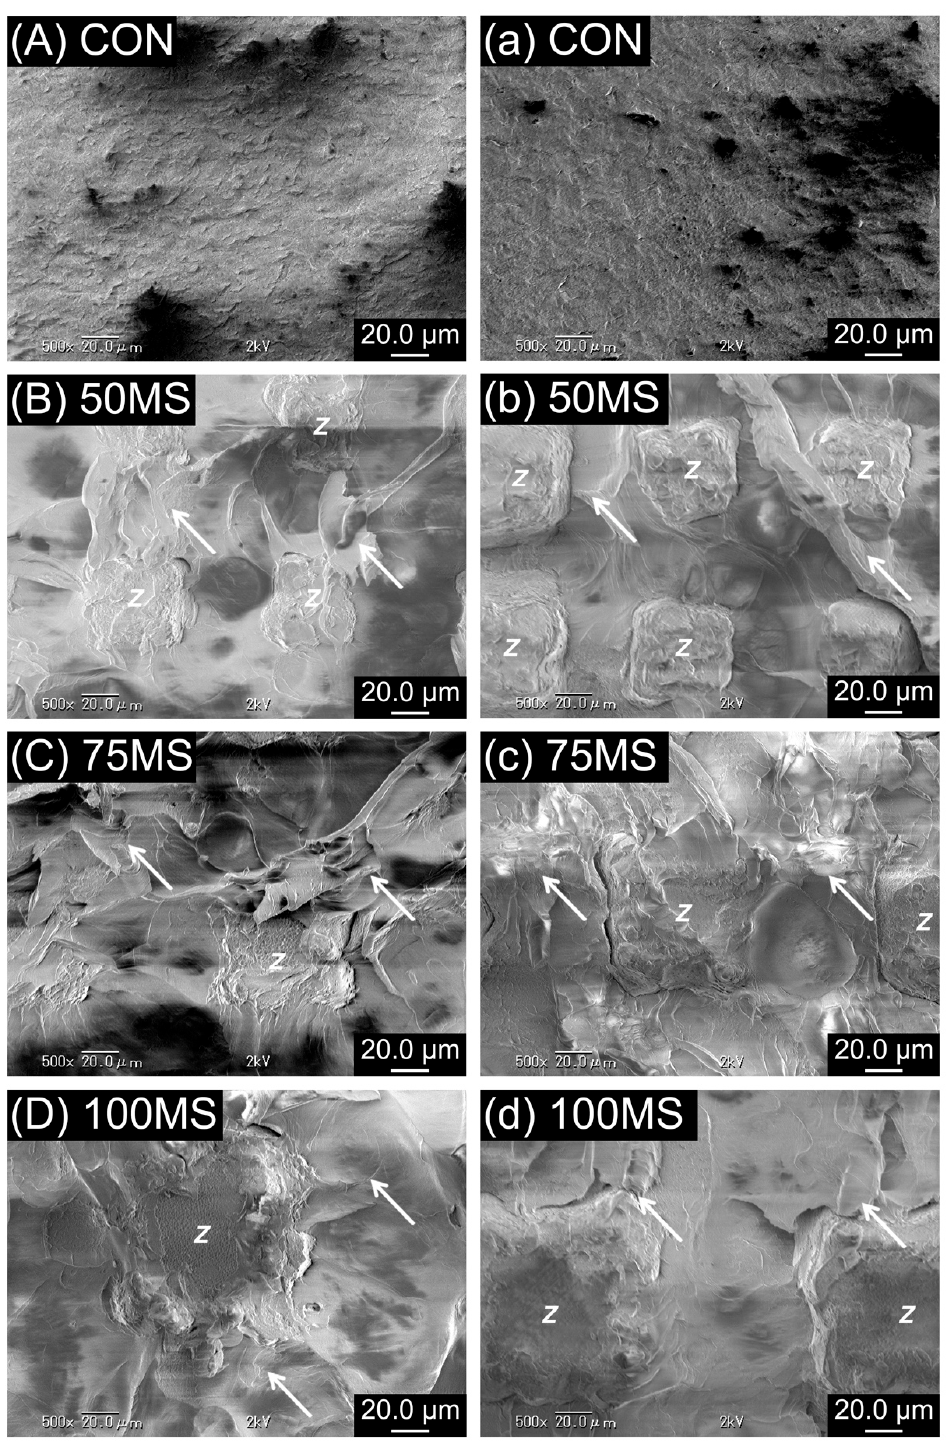
Figure 5. Scanning electron micrographs (SEM) of debonded Ce-TZP/A and acrylic resin interface before ( A – D ) and after artificial aging ( a – d ). The arrow in the figure refers to the residual acrylic resins, while the Latin script letter Z refers to zirconia ceramics; original magnification 500×.